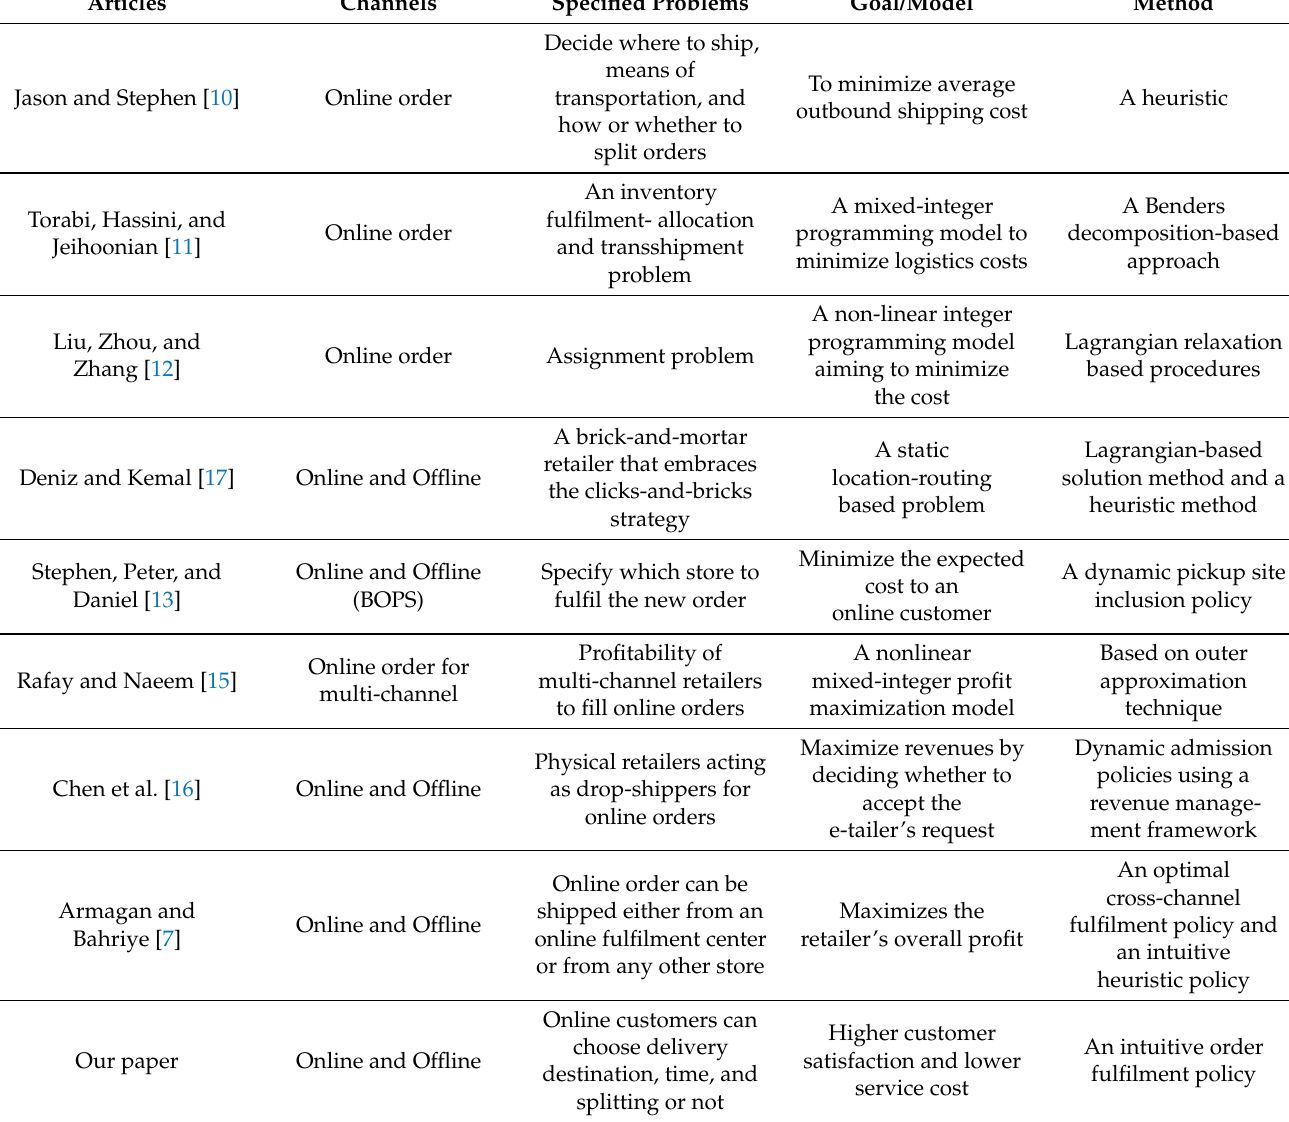
Table 1. Main work of related